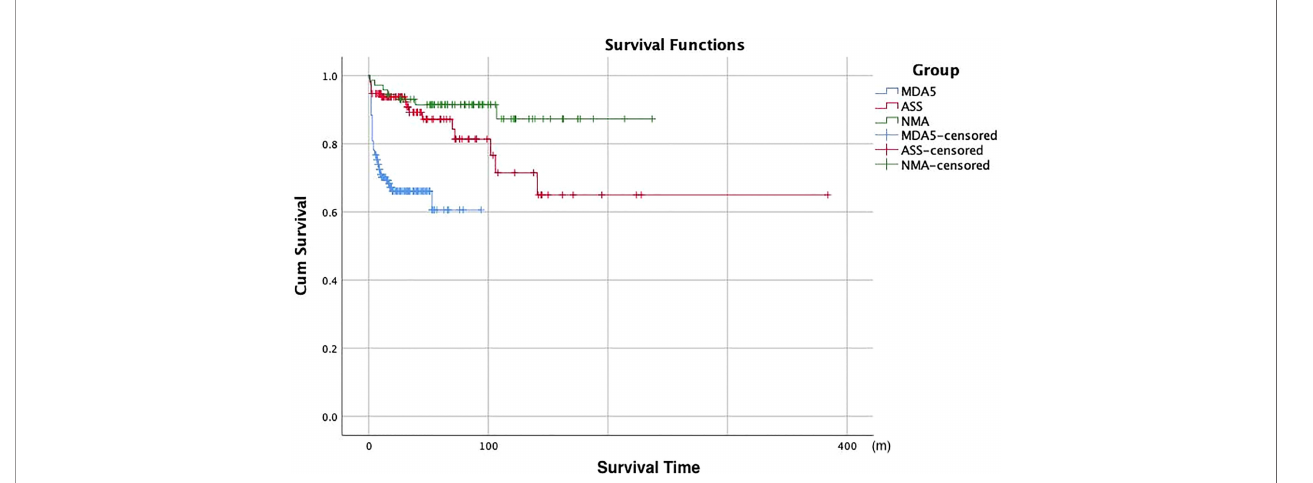
FIGURE 3 | Kaplan-Meier survival analysis of ILD patients with negative MSA/MAA,MDA5 + DM patients and ASS patients. NMA, negative myositis